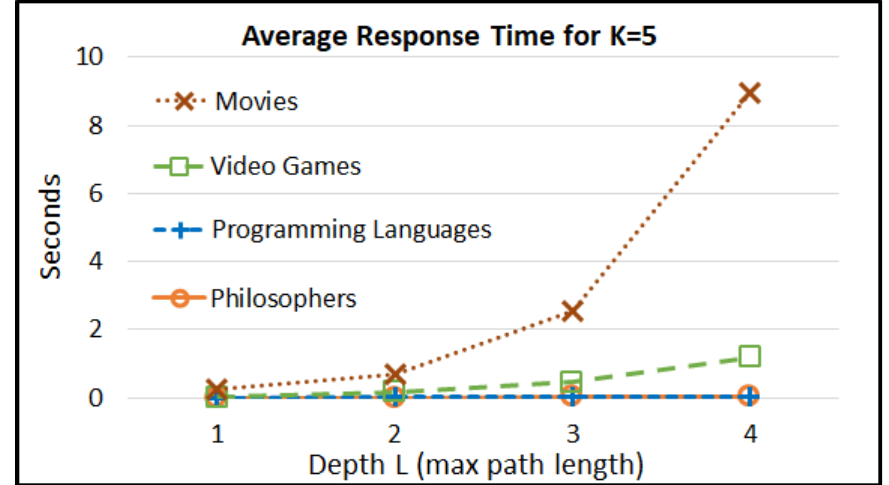
Figure 10. Average time for creating the similarity graph for K = 5.